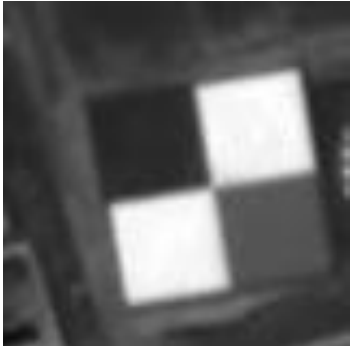
Figure 13. GF-1 panchromatic image of knife-edge